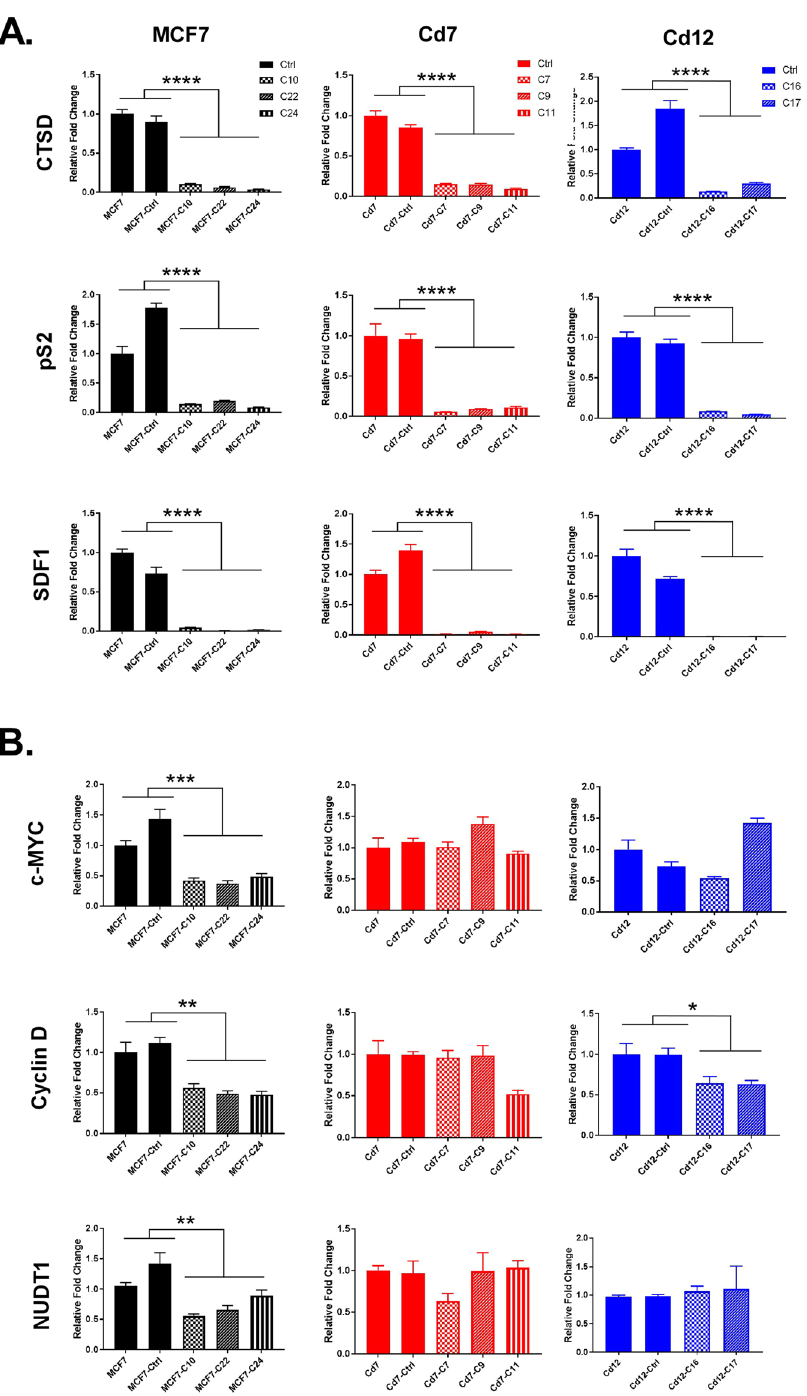
Figure 3. The effect of ER α knockout on the expression of classical and non-classical ER α genes. ( A ) Gene expression of the classical ER α genes CTSD, pS2, and SDF1 and the ( B ) non-classical genes, c-myc and cyclin-D1, and the estrogen-responsive gene NUDT1 were measured using RT-qPCR. MCF7-, Cd7-, and Cd12- Ctrl indicate the cells transfected with a CRISPR control plasmid. MCF7 was used as the control and all relative fold changes were normalized to actin (relative fold = 2 ΔΔ Ct gene/ ΔΔ CtActin ). The results represent the average of three independent experiments of quadruplicate samples ( * p < 0.05; ** p < 0.01; *** p < 0.001; **** p <